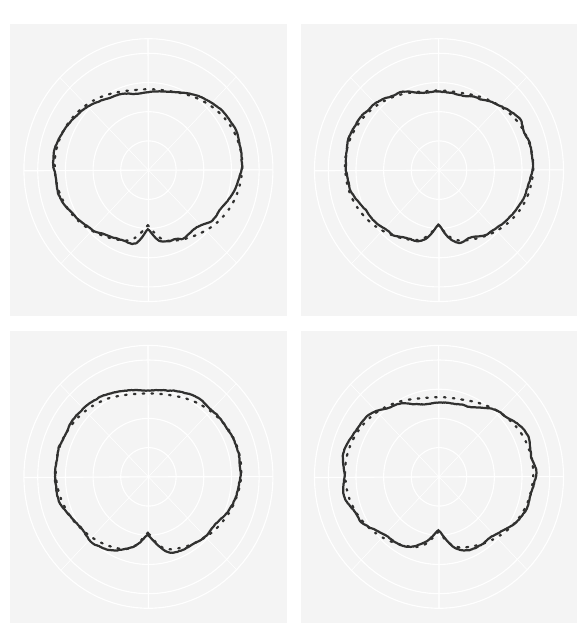
Figure 9. Visualization of the predicted and observed shapes for four observations. The solid lines are the original observed shape (averaging the twenty-five shapes for each observation), and the dot lines are the predicted shape output from the FunFor approach by fivefold